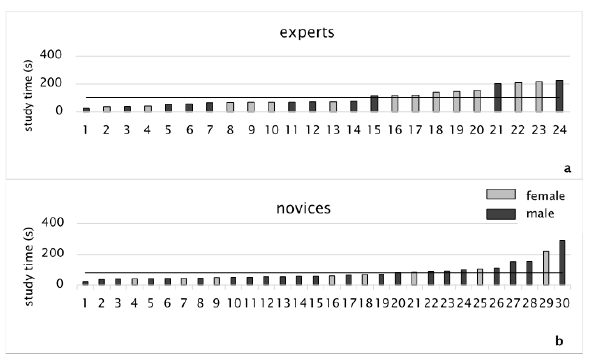
Figure 4. Study time of experts (a) and of novices (b) (black line: average)